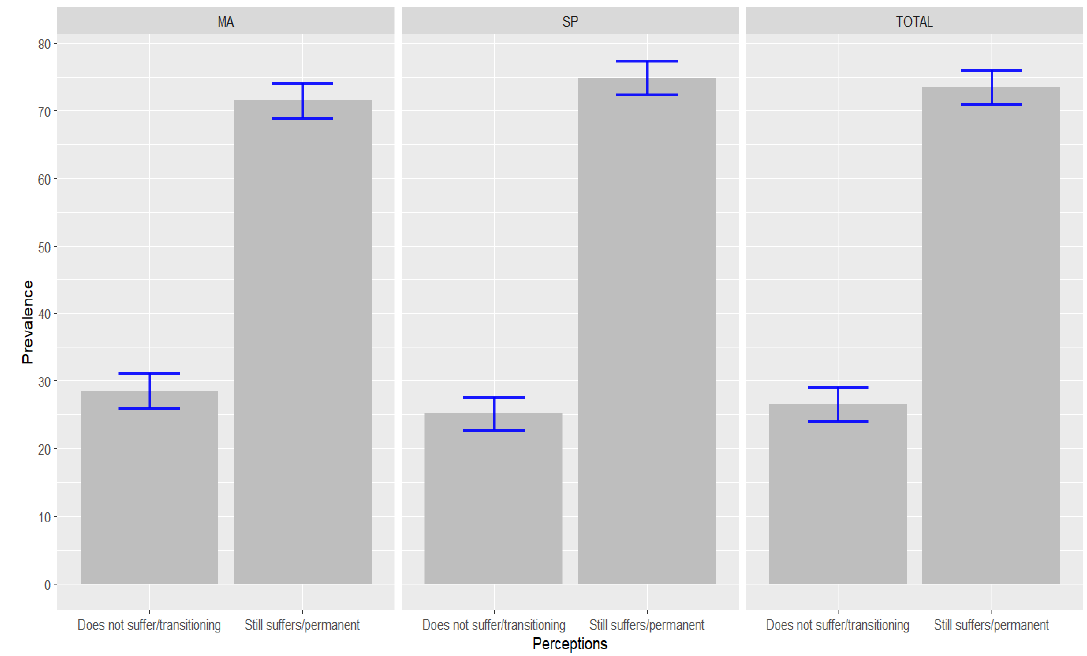
Figure 1. Perceptions of the impacts of the COVID-19 pandemic on work dynamics among physicians interviewed in SP and MA, Brazil, 2021. Blue lines: 95% Confidence Interval (95% CI). Source: Survey on the Labor Market and Impact of the New Coronavirus, in the States of SP and MA, Brazil, 2021.